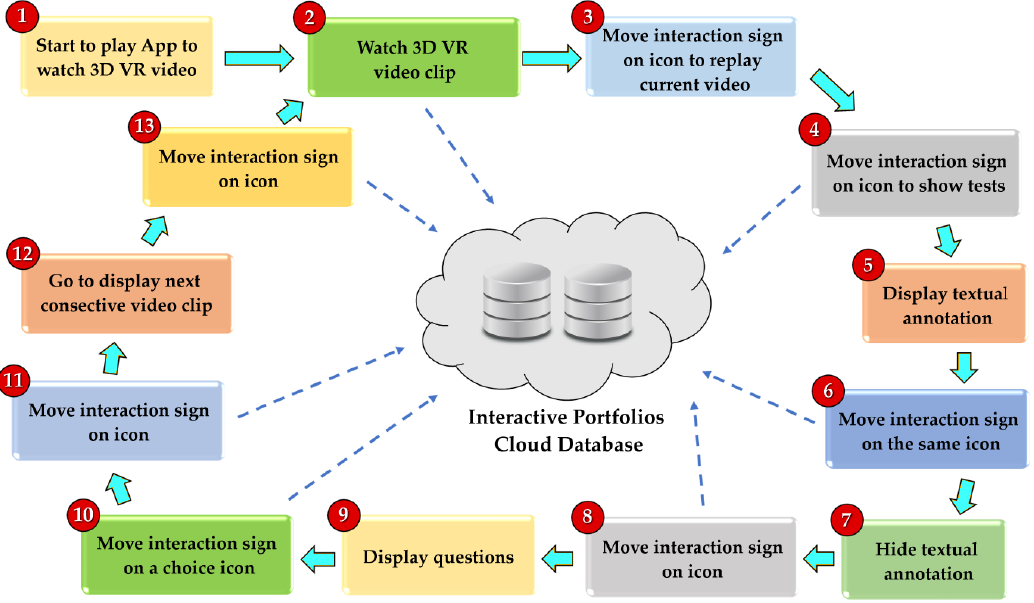
Figure 11. Learning procedure while watching the 3D VR video using a VRAM Android app. Table 3. Steps for actions in Figure 11.